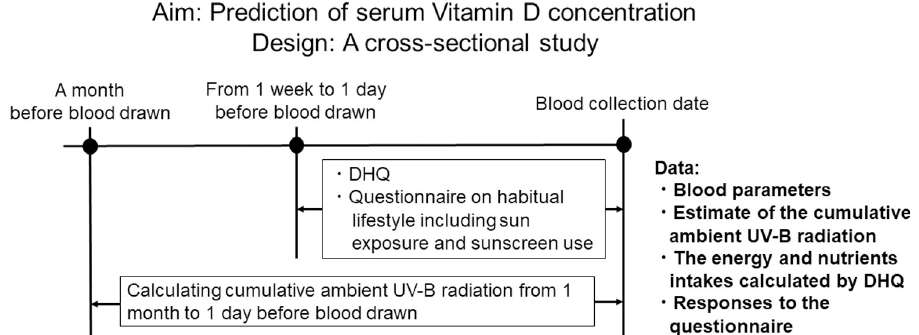
Fig 2. The study schedule in each season. A cross-sectional study is conducted for 600 young women in four regions (Hokkaido/Tohoku, Kanto, Chubu/Kinki/Shikoku, and Kyushu/Okinawa) of Japan from 2020 to 2022. This study is performed twice in the summer (June to September) and in the winter (December to February) in each region. The figure describes the study schedule in each